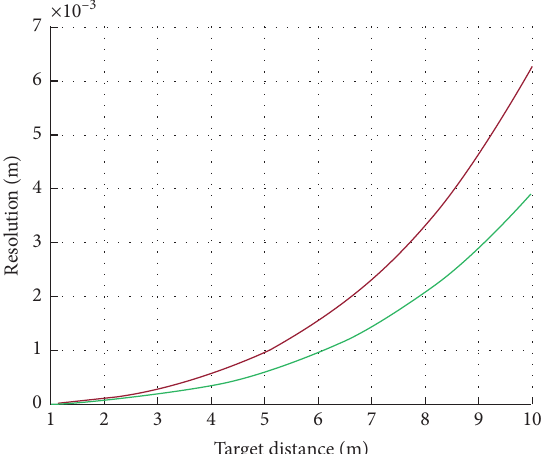
Figure 4: Picture of the TRIGA RC1 reactor vessel with the fuel rods’ circular array on the bottom and taken with a high-quality commercial photographic